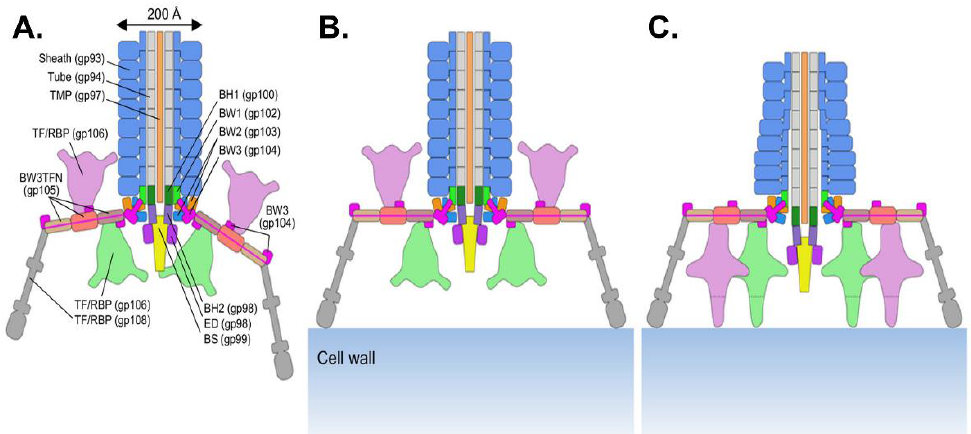
Figure 9. Listeria phage A511 baseplate structure and baseplate transformation upon adsorption . ( A ) Phage A511 tail structure. The name of each tail protein is indicated with the related gene in parentheses. ( B ) A511 first interaction with the CW through binding of the RBP gp108. ( C ) Reorientation of the gp106 pyramidal structures and interaction with the CW. The distal part of the sheath begins to contract. BH: Baseplate Hub; RBP: Receptor Binding Protein; BW: Baseplate Wedge; BS: Baseplate Spike; TF: Tail fiber; TFN: Tail Fiber Network. Reprinted with permission from